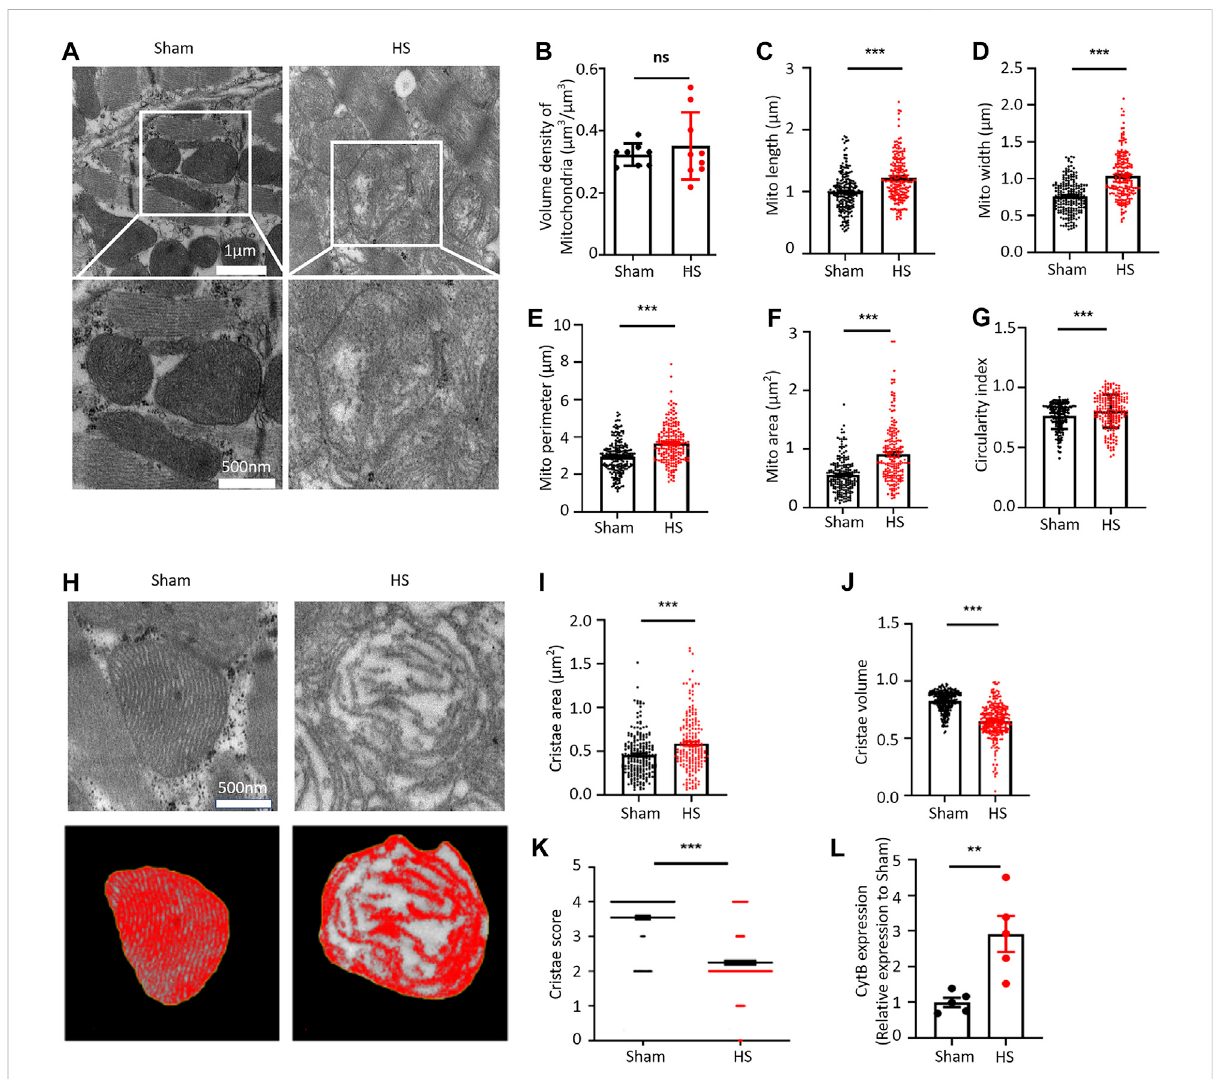
FIGURE 1 HS damages the myocardial mitochondrial ultrastructure and increases the mtDNA release. (A) Representative transmission electron microscopic (TEM) images of mitochondria in the myocardial tissue of rats from the sham group and HS group. (B – G) Statistical results of the myocardial mitochondrial volume density, length, width, perimeter, area, and circularity index in the sham group and HS group. ImageJ was used to quantitatively analyse themyocardialmitochondrialmorphology, n =200mitochondriafrom5ratsineachgroup, *** p < 0.001comparedwith the sham group. (H) Representative TEM images of myocardial mitochondrial cristae ultrastructure of the sham group and HS group rats. (I – K) Statistical results of the mitochondrial cristae area, cristae volume, and cristae score, n = 200 mitochondria from 5 rats per group, *** p < 0.001 compared with the sham group. (L) Statistical results of the mitochondrial DNA CytB content in peripheral blood of the sham group and HS group. n = 5 rats per group, *** p < 0.01 compared with the sham